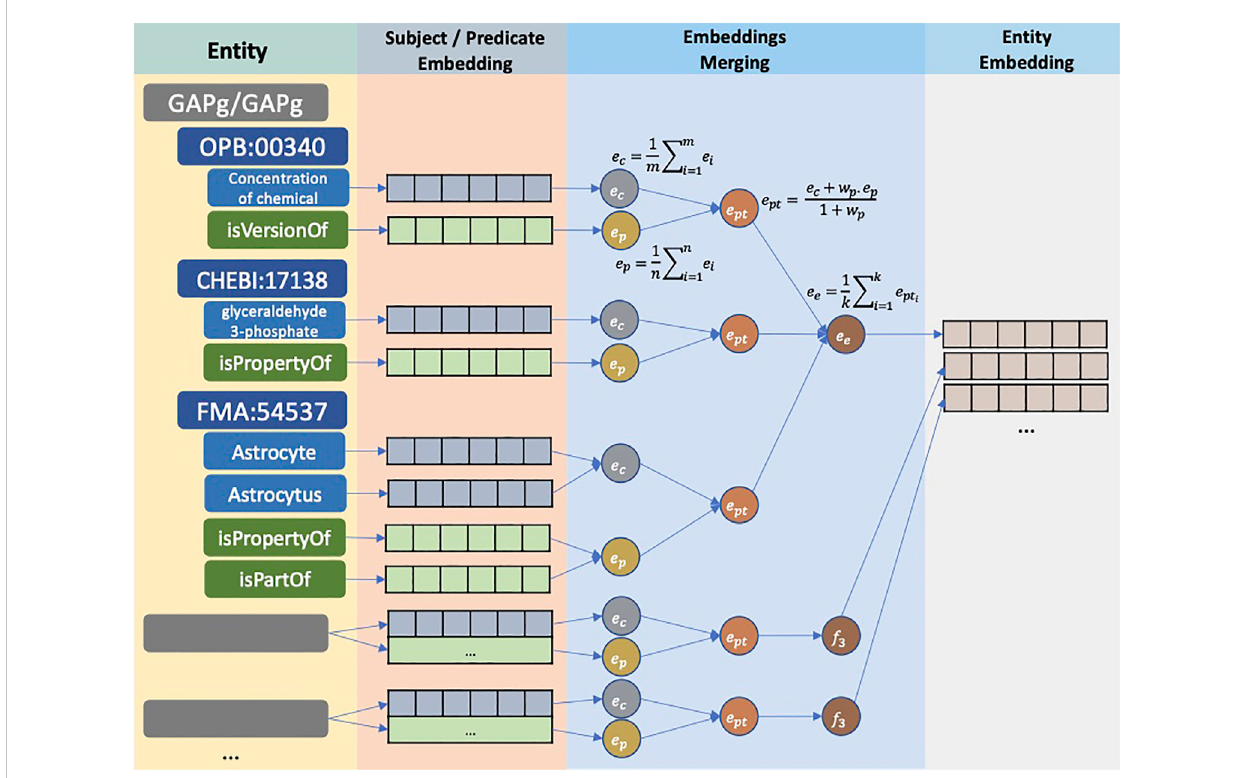
FIGURE 2 The conversion of entities to entity embeddings. For each entity, ontology classes and predicates are encoded into embeddings. Embeddings of ontology classes and predicates in one path are combined to form path embedding. Finally, all path embeddings are combined using the average function, creating an entity